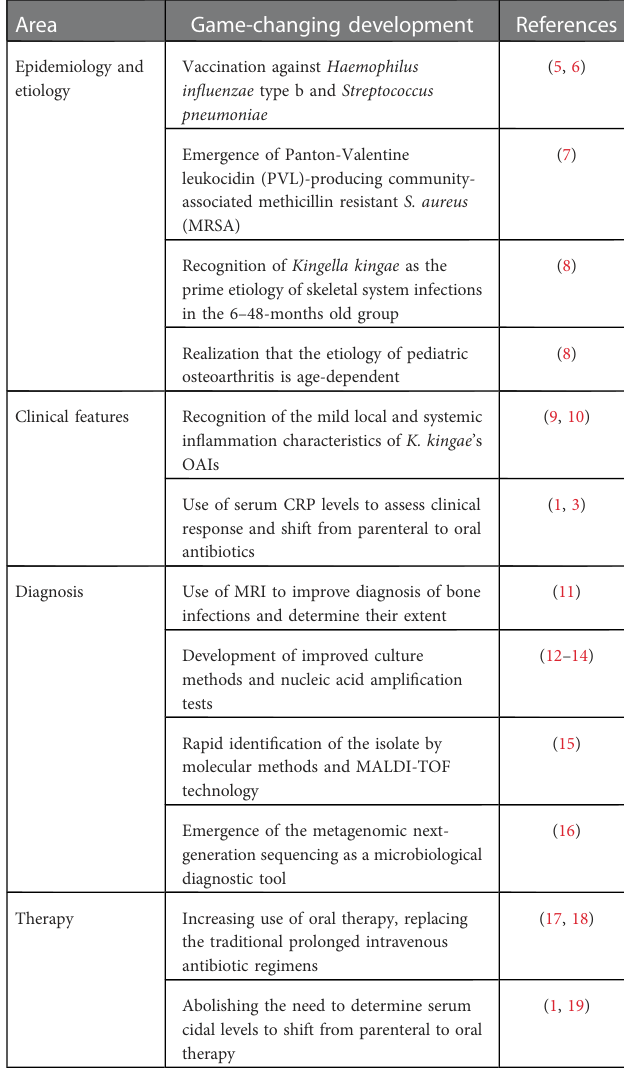
TABLE 1 Main developments that have changed the management of pediatric skeletal system infections in recent